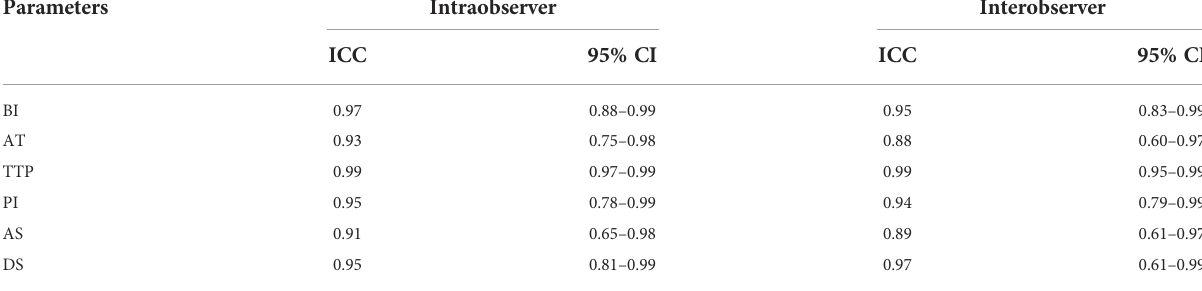
TABLE 5 Intraobserver and interobserver reliability of CEU